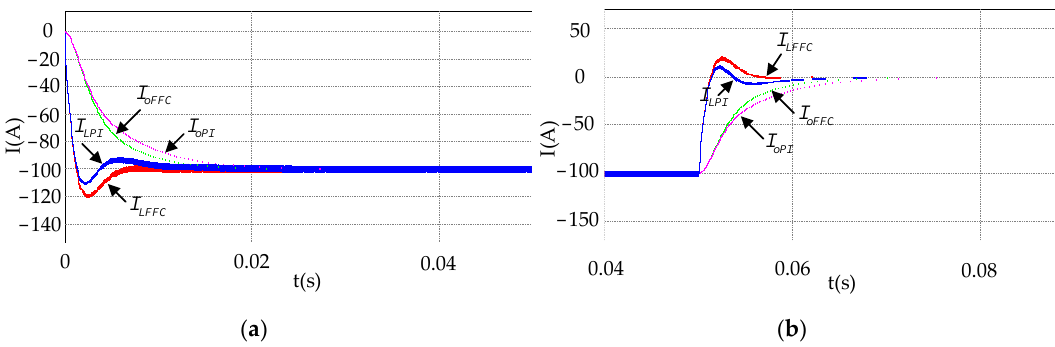
Figure 12. Waveforms of start-up and turn-off processes in discharging mode. ( a ) Start-up waveform from 10% to 90% with PI and duty ratio feedforward control methods. ( b ) Turn-off waveform from 10% to 90% with PI and duty ratio feedforward control methods. Electronics 2020 , 9 , x FOR PEER REVIEW